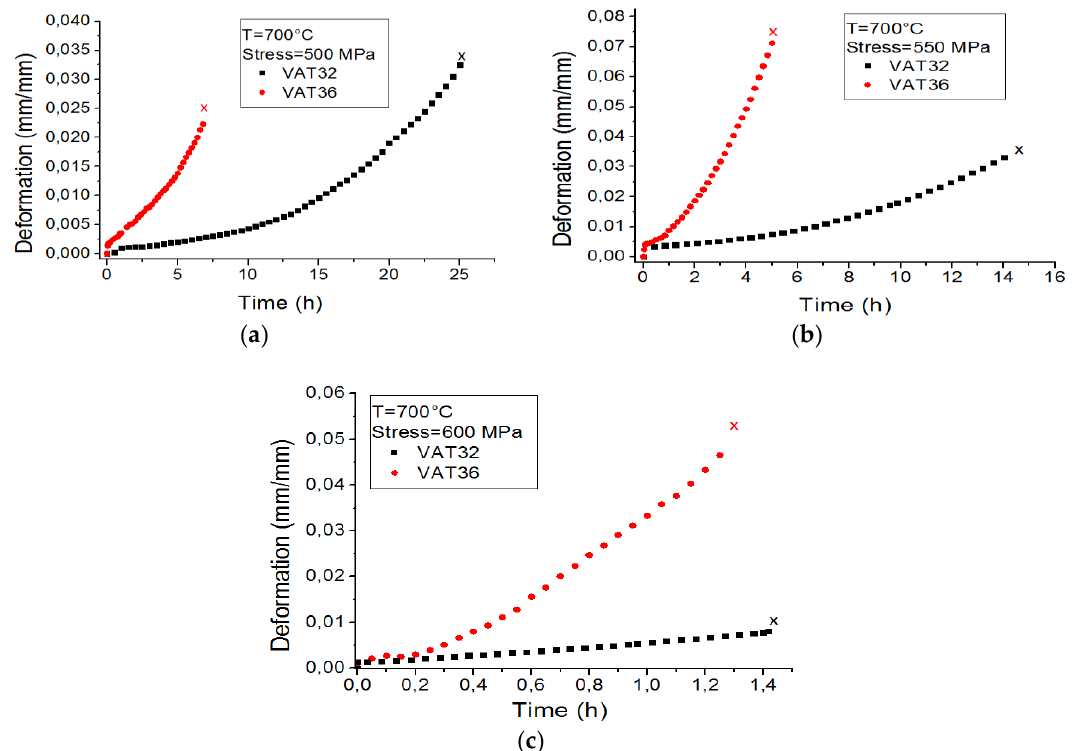
Figure 9. Creep curves of the alloys VAT 36 and VAT 32 at 700 °C at the stress of: ( a ) 500. ( b ) 550 and ( c ) 600 MPa.